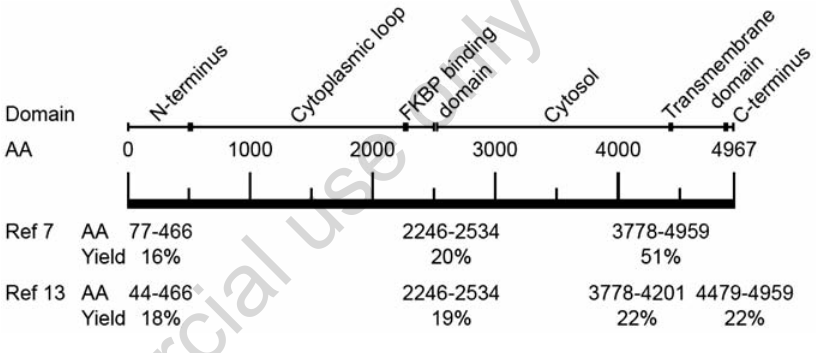
Figure 1. RyR2 structure and mutation clustering. Yield indicates the proportion of RyR2 mutations identified per domain (indicated by the aminoacid number estimated for each domain). AA, amino acid. Adapted from Medeiros-Domingo et al. 7 and Priori et al. 13